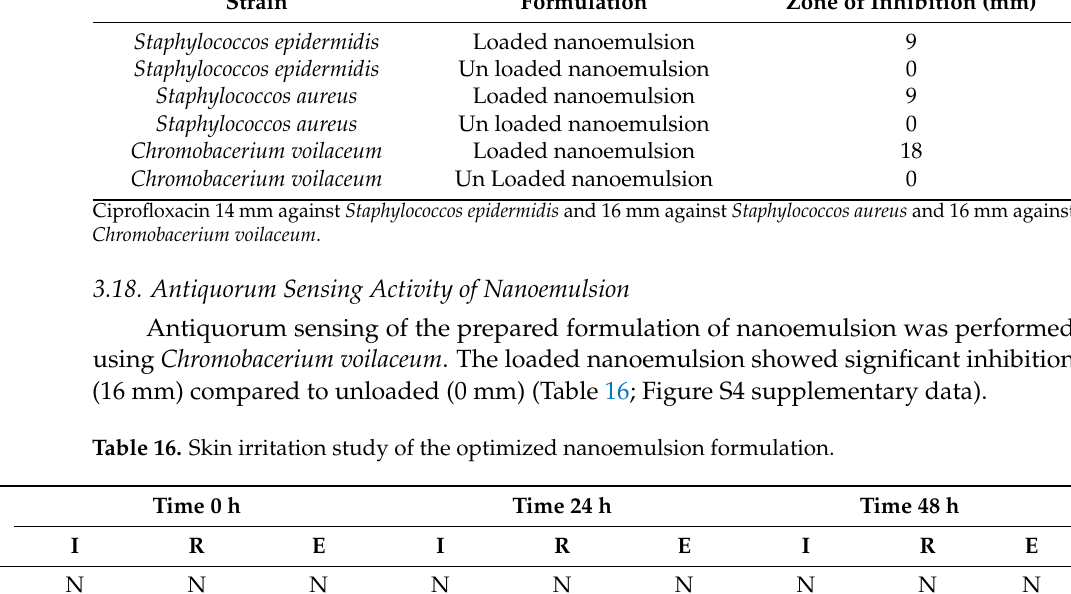
Table 15. Antibacterial activity and Antiquorum sensing of essential-oil-loaded nanoemulsion. Strain